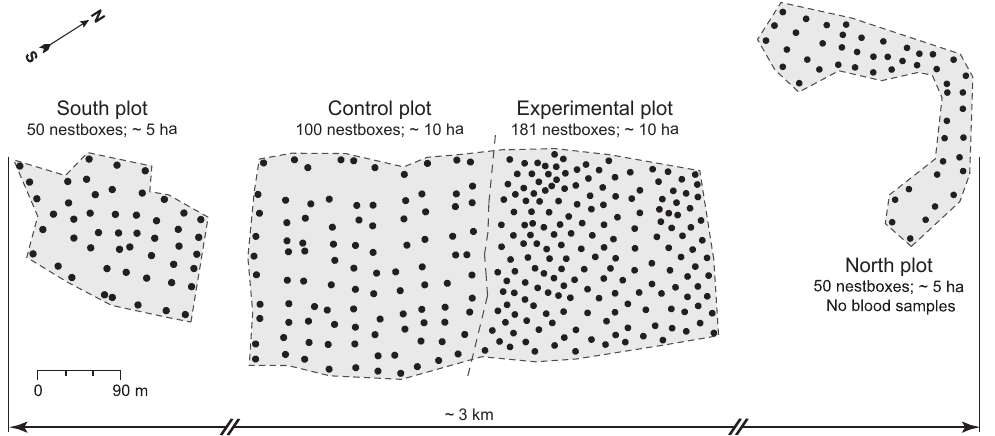
Figure 1. A simplified map of the study area. The map shows all the plots, their areas, and the number of nest-boxes at each